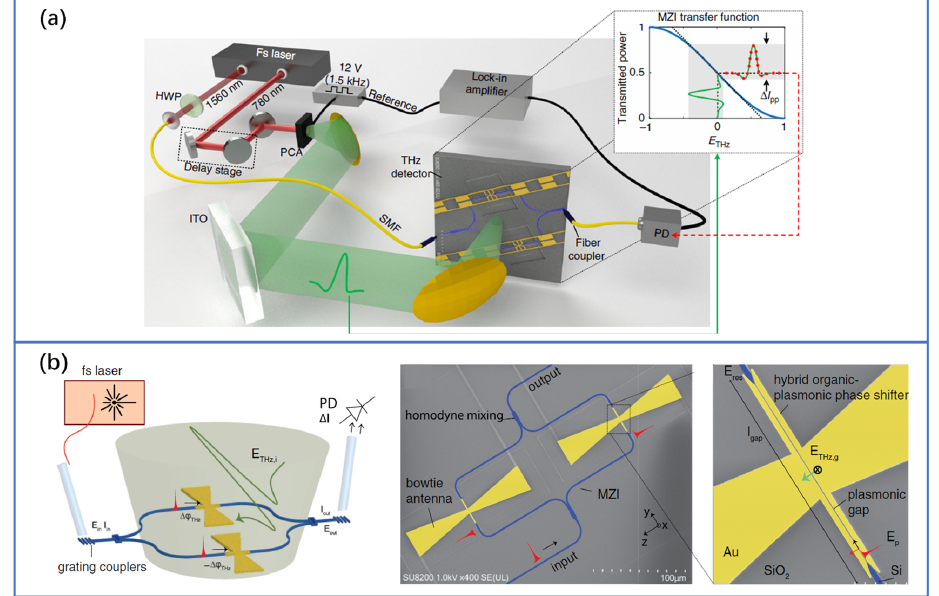
Figure 8. ( a ) THz time-domain EO sampling setup using the integrated plasmonic THz field detector consists of a Mach - Zehnder interferometer (MZI) with antenna-coupled plasmonic phase shifters. Reproduced with permission from [115], Copyright, Springer Nature, 2019. ( b ) THz time-domain EO sampling setup using an integrated detector with the bowtie antennas together with the layout of the detector. Reprinted (adapted) with permission from [56] © The Optical Society, 2020.